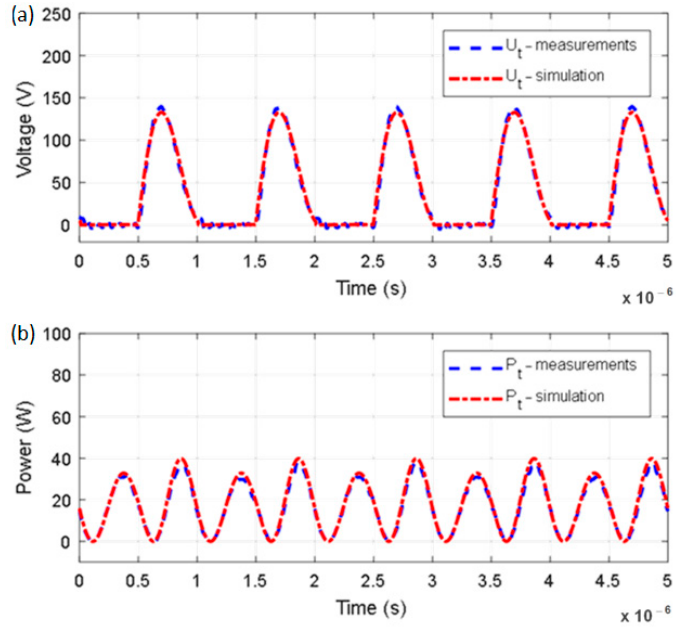
Figure 16. The comparative waveforms of simulation and experimental results: ( a ) transistor voltage drop U T and ( b ) transmitted power P T .